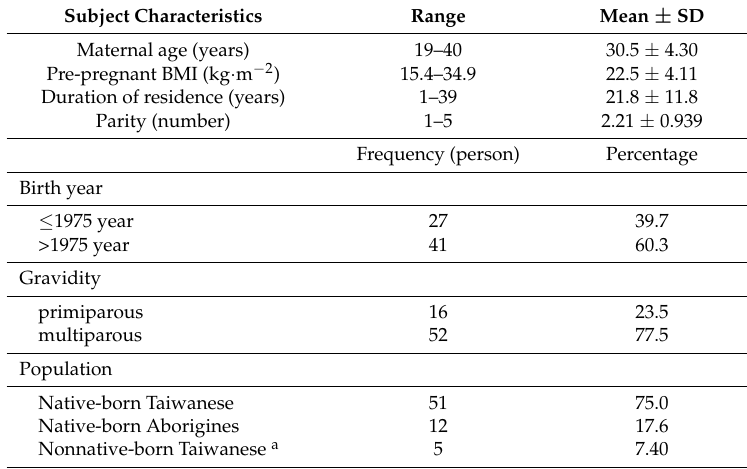
Table 1. Descriptive statistics of demographic or sociodemographic characteristics in the pregnant women ( n =